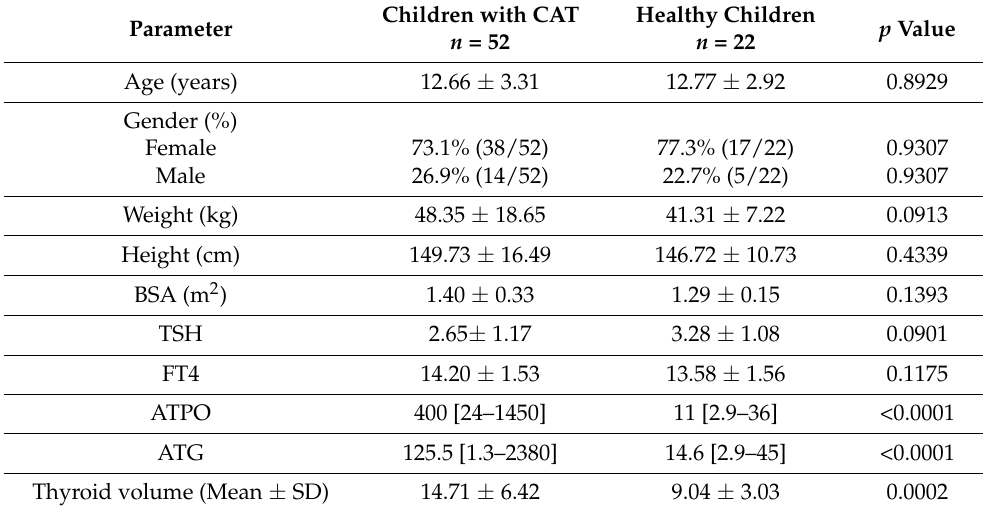
Table 1. Main characteristics of the study group.